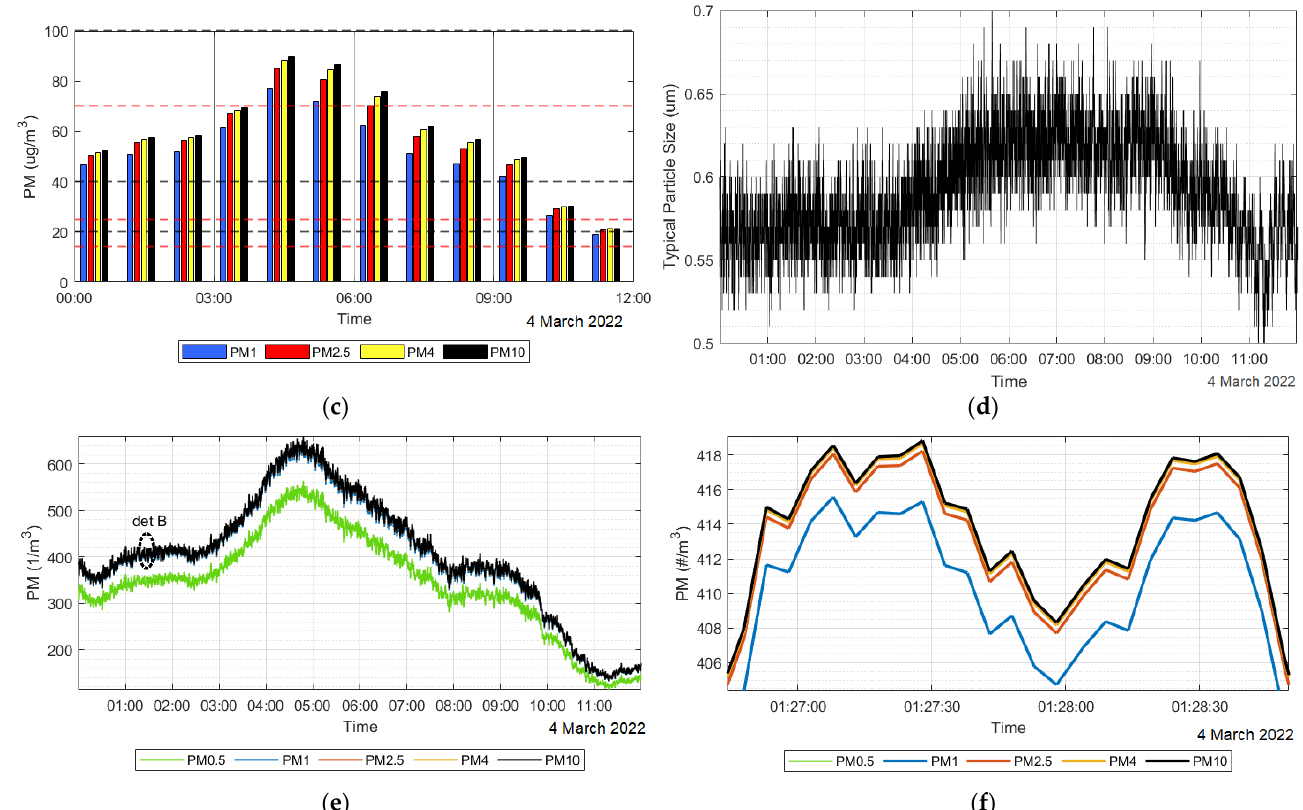
Figure 6. Sample of measured PM at DTIEE 4 March 2022 from 0:00 to 12:00 a.m.: ( a ) mass concentration of PM1 (blue), PM2.5 (red), PM4 (yellow), and PM10 (black), ( b ) detail from Figure 6a, ( c ) hourly averages of PM mass concentrations, where dashed lines correspond to the upper limits of very good (VG), good (G) or worsened (W) air quality for hourly mass concentrations of PM2.5 (red dashed line) and PM10 (black dashed line), where PM1, PM2.5 and PM4 are very close to PM10, ( d ) typical particle size, ( e ) number concentration of PM0.5 (green), PM1 (blue), PM2.5 (red), PM4 (yellow) and PM10 (black), ( f ) detail (det B) from ( e ), where PM0.5 (green) is not included in the figure due to the close up.